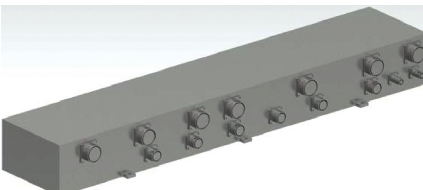
Figure 4: The schematic diagram of external for array power supply.